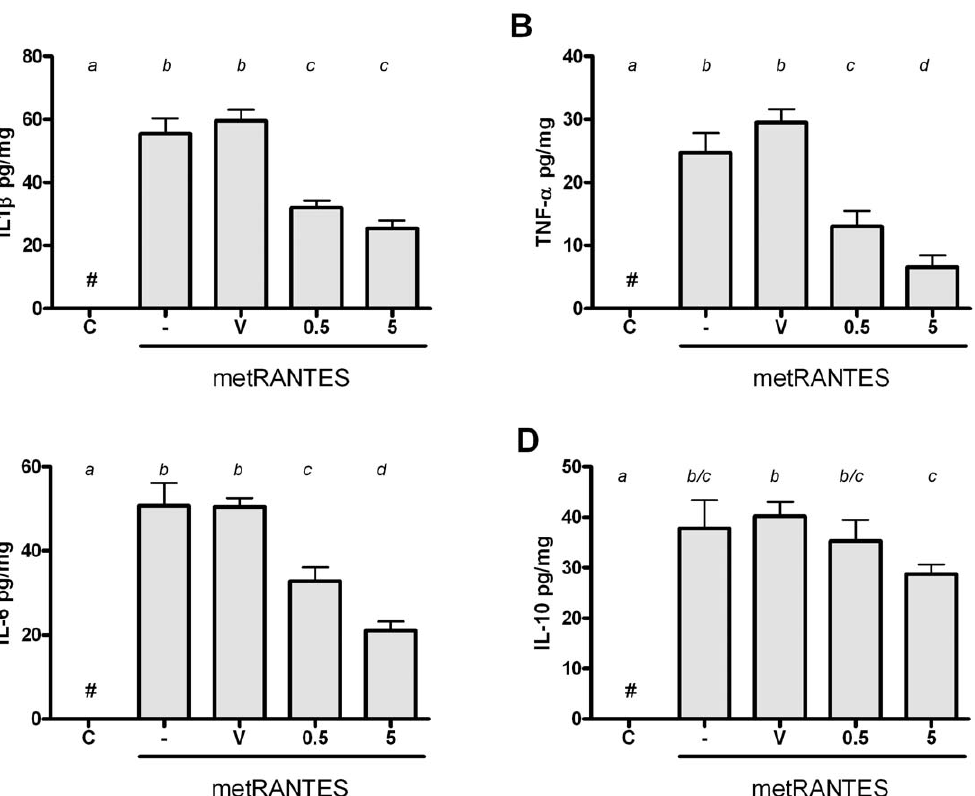
Figure 3. Met-RANTES treatment at different doses modulate pro- and anti- inflammatory cytokine levels in experimental periodontal disease. C57Bl/6 mice were infected orally with AA , treated with met-RANTES at 0.5 and 5 mg doses or (V) veicule, (-) non treated and (C) control non-infected mice, sacrificed at day 30 post-infection and evaluated for levels of A) IL-1 b ; B) TNF- a ; C) IL-6 and D) IL-10 cytokines. Different italic low case letters represent statistically significant differences among the doses in the same experimental group (P , 0.05; One-way ANOVA).